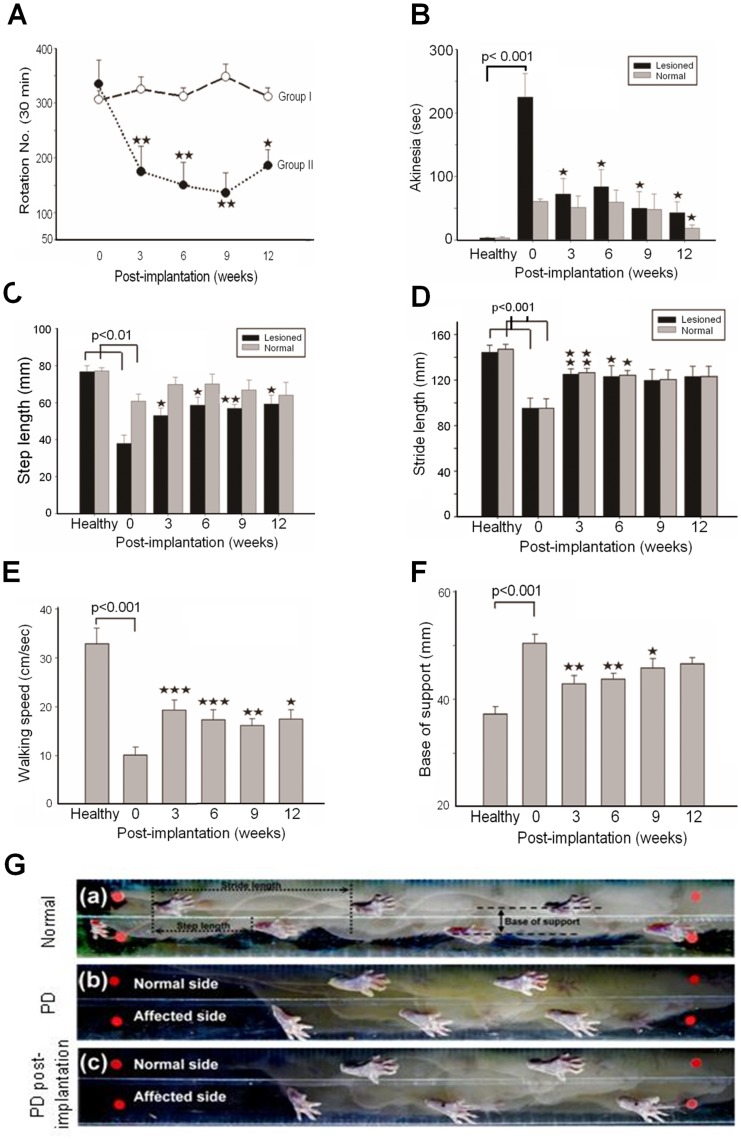
Behavioral Assessments in Chronic PD Rats.(A) Apomorphine-induced rotations analysis revealed a significant improvement in chronic PD rats that received tNSCs cell therapy (Group II, n = 6, black round line) compared to the control group (Group I, n = 6, blank round line). (B) Bar tests (sec) improved at 3-week post-cell therapy. (C) Shortened step length and (D) stride length were significantly improved after 3-week post-cell therapy in PD rats. (E) Significant improvement in walking speed (cm/sec) in PD rats at 3-week post-cell therapy. (F) Significant shortening in base of support (mm) was seen at 3-week post-cell therapy. (G) A well-designed cage with a video camera for footprint analyses. (a): in normal rats, (b): in PD rats pre-cell therapy, and (c): post-cell therapy. Asterisk: compared to the control. Student’s t test: *:p<0.05; **: p<0.01; and ***: p<0.001.